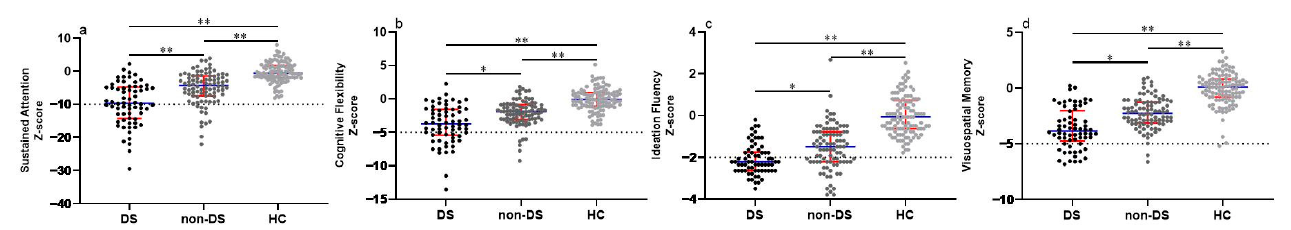
Figure 1. Comparison of cognitive function among DS, non-DS patients, and HCs. ( a ) Comparison of sustained attention among groups. ( b ) Comparison of cognitive flexibility among groups. ( c ) Comparison of ideation fluency among groups. ( d ) Comparison of visuospatial memory among groups. Each bar represents the Median score of cognitive domains. Error bars represent the interquartile range (IQR). Abbreviations: DS = deficit syndrome; HC, healthy controls. * Bonferroni corrected p < 0.01 between groups. ** Bonferroni corrected p < 0.001 between groups.